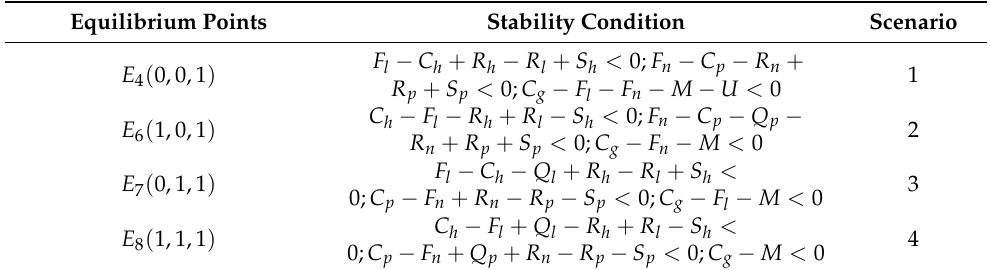
Table 3. Equilibrium stability conditions of the system. Equilibrium